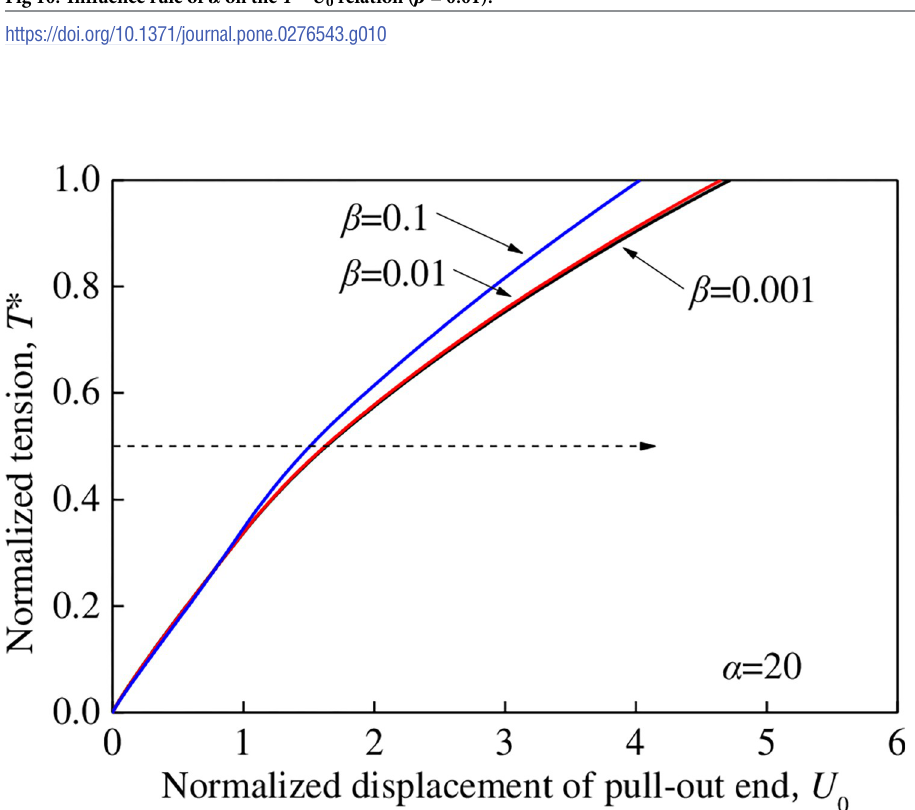
Fig 11. Influence rule of β on the T � –U 0 relation ( α = 20).